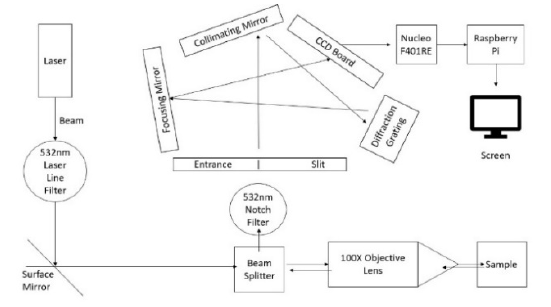
Fig. 4: Raman spectrometer system with each part labelled and assembled